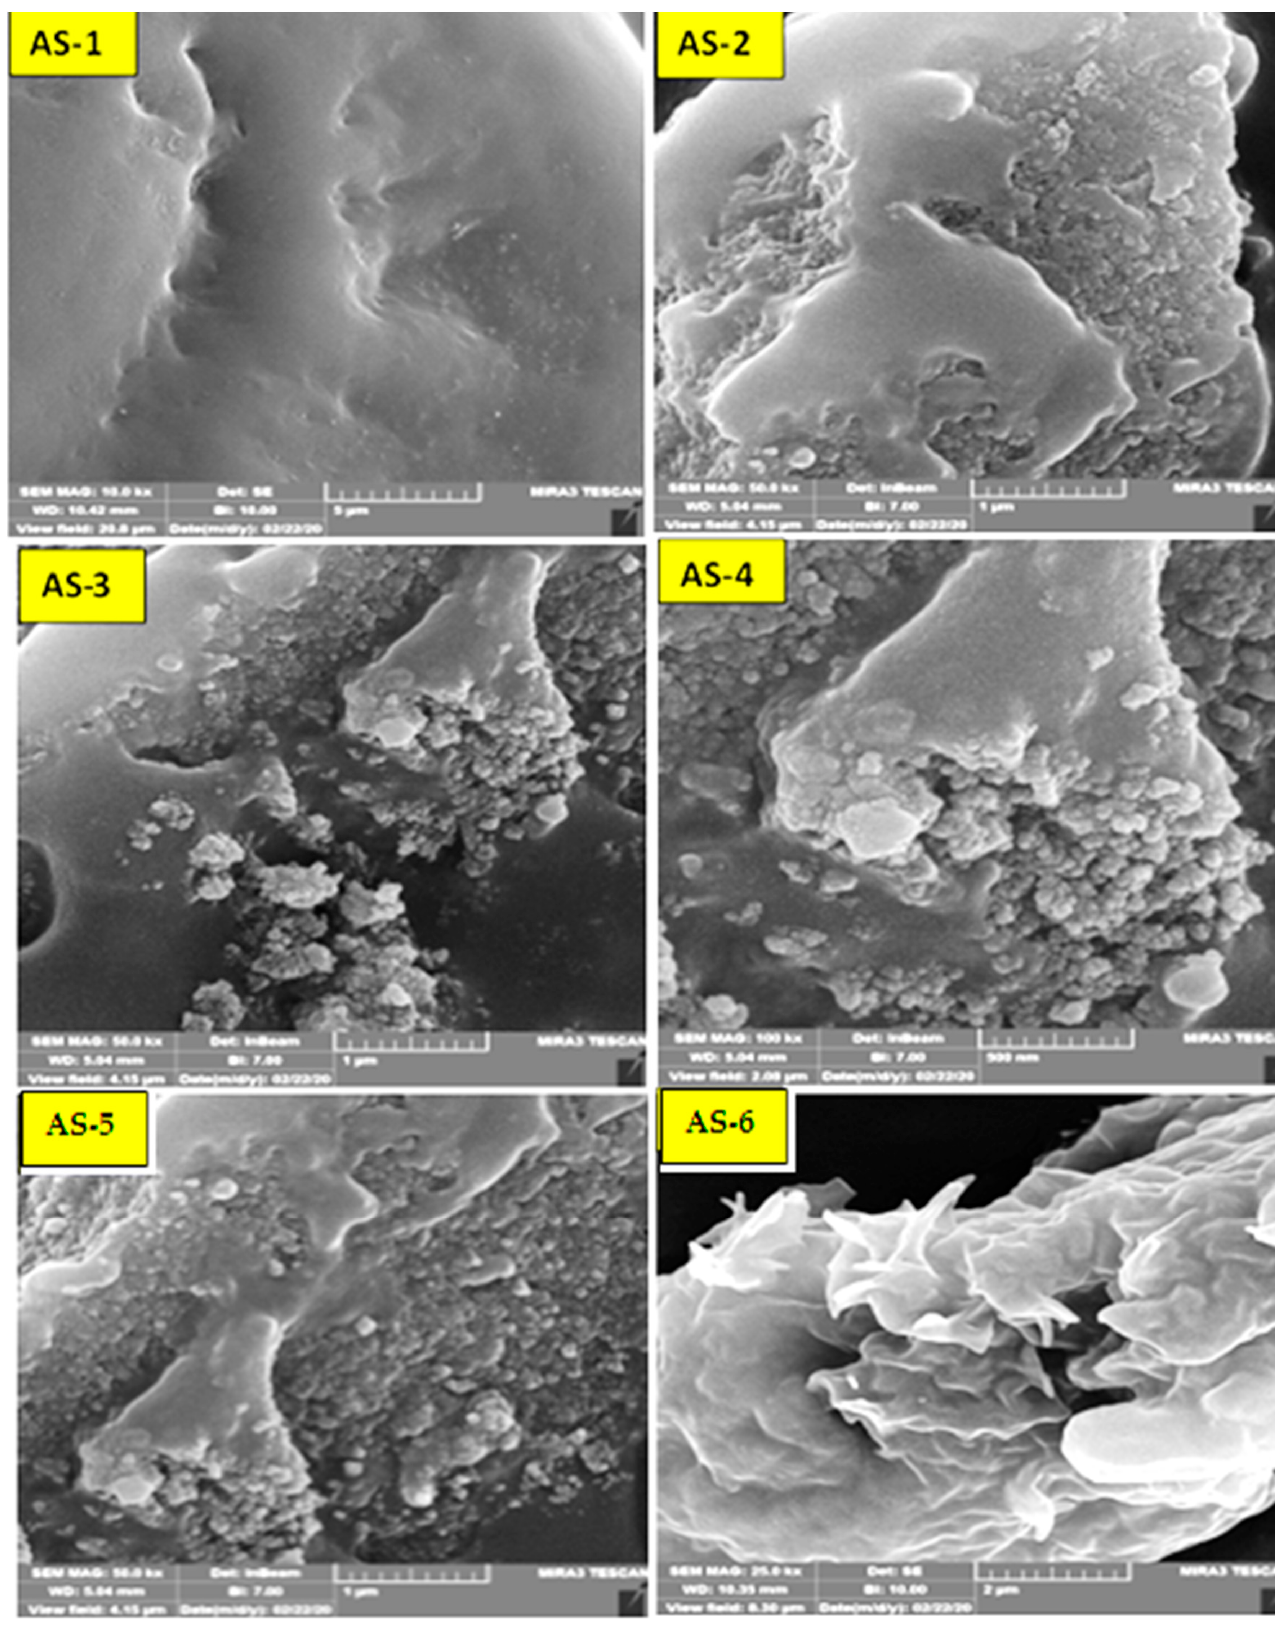
Figure 7. FE-SEM for PW and ULO-modified asphalt samples.